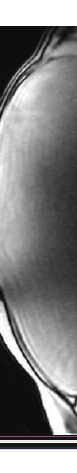
Figure 2: MRI abdomen.